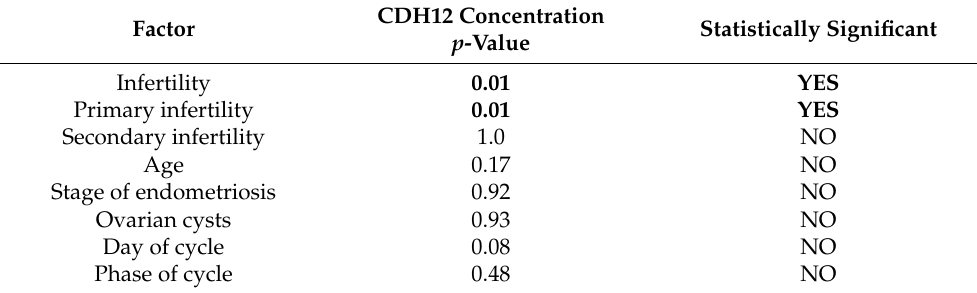
Table 2. Statistical significance of CDH12 concentrations depending on different factors.